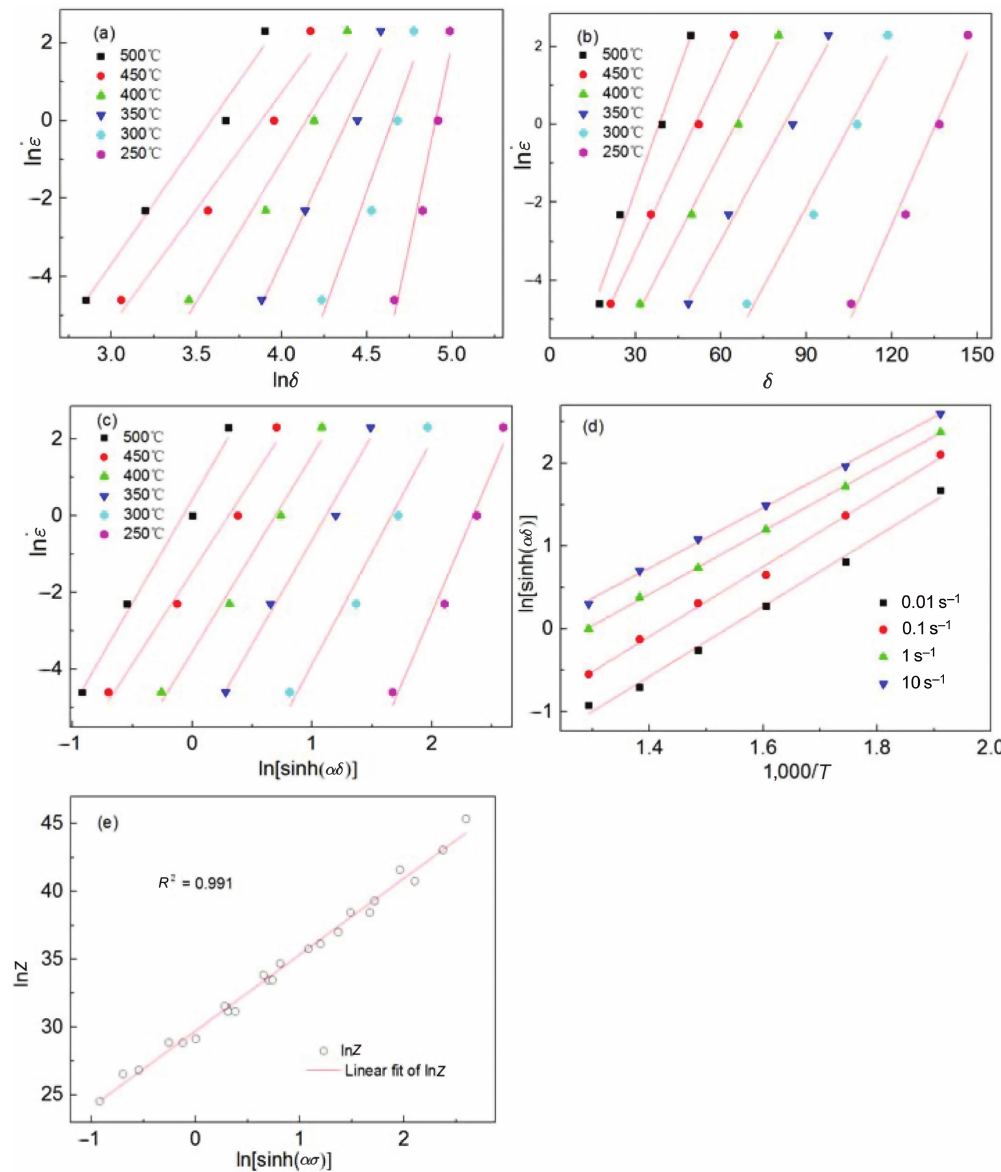
Figure 3: Hyperbolic sine relation between hot deformation and flow stress: (a) ln δ (cid:2) ln _ " ; (b) δ (cid:2) ln _ " ; (c) ln _ " (cid:2) ln sinh αδ ð Þ½ (cid:3) ; (d) ln Z – n ln[sinh ( ασ )] – 1,000/ T and (e) ln Z – ln[sinh( ασ